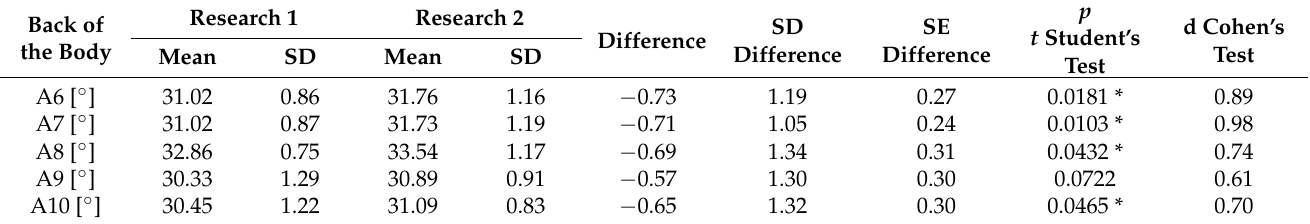
Table 2. Posterior body temperature measured before and after